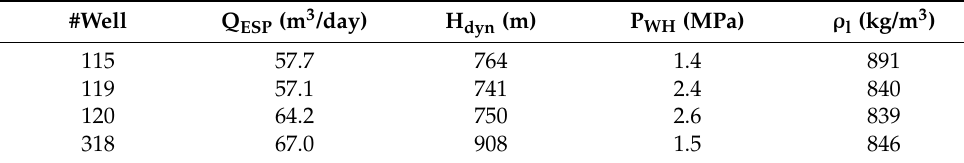
Table 2. Values of technological parameters used in simulation.